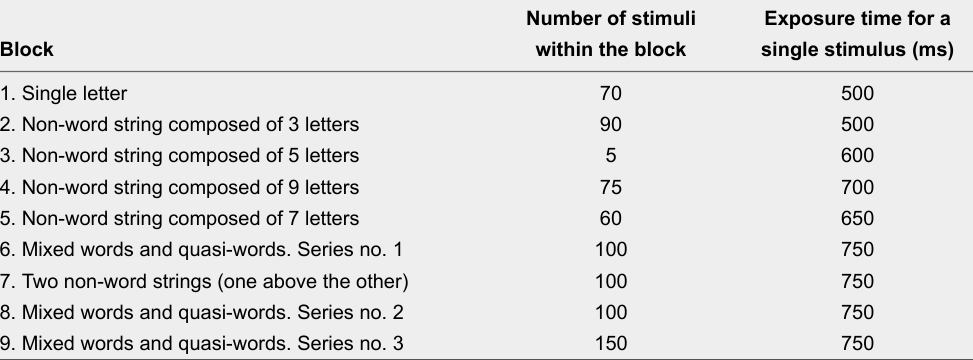
The Details of Blocks of Stimuli Used in the Attentional Task